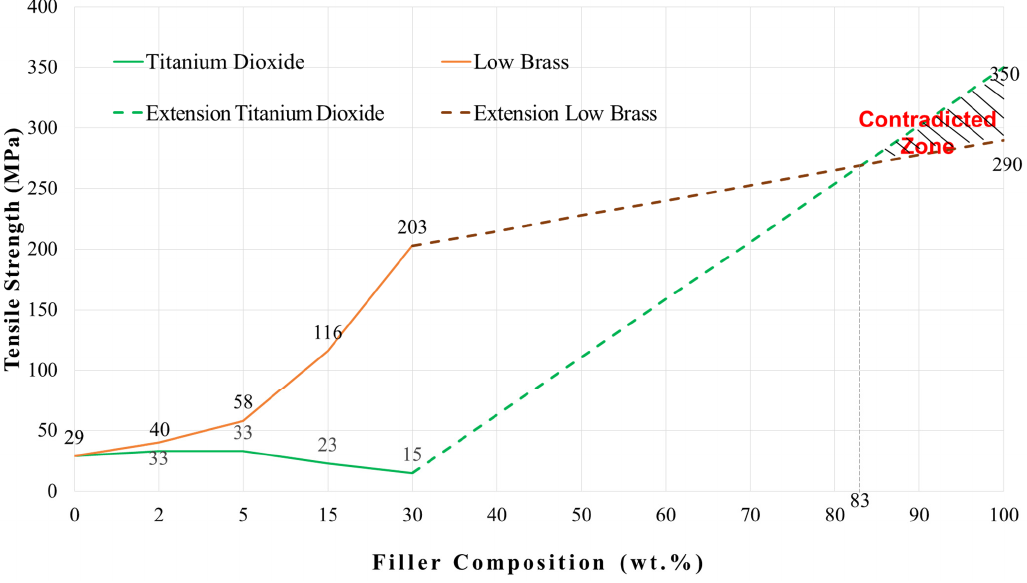
Figure 3. The contradicted zone between the extended curves of low brass and titanium dioxide filler tensile strengths.